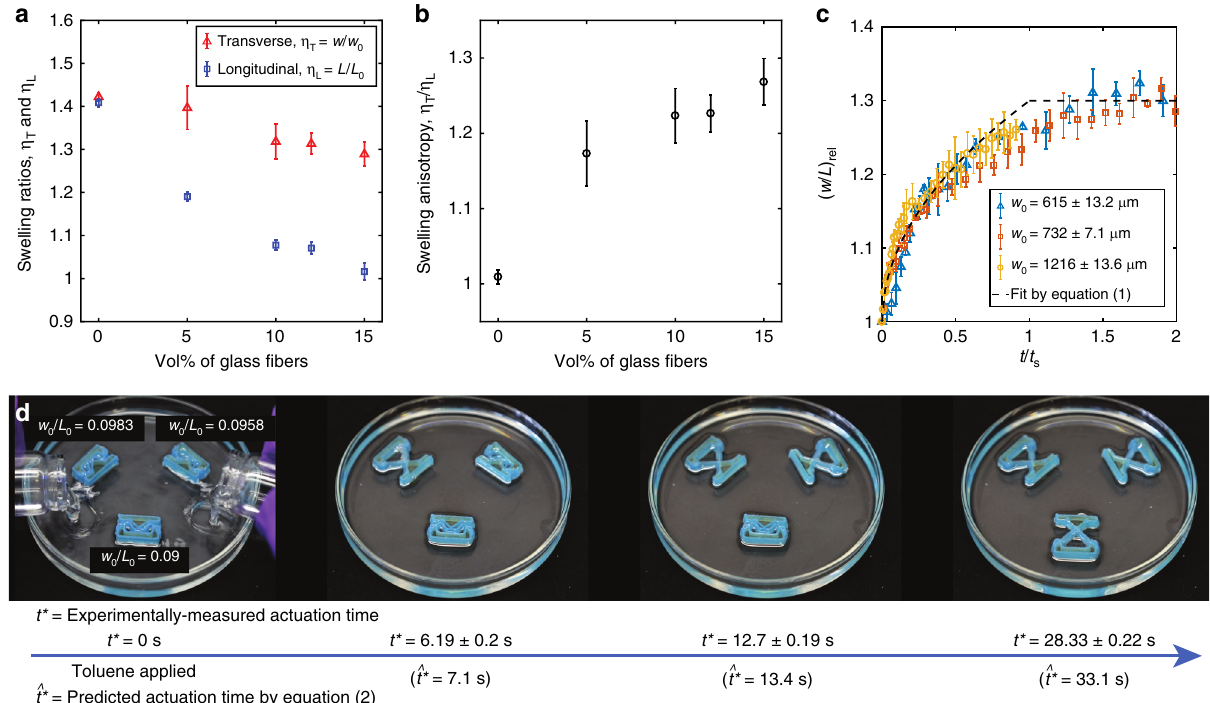
Fig. 4 Control of actuation time. a Swelling ratio in the transverse ( η T = w/w 0 ) and longitudinal ( η L = L / L 0 ) directions for PDMS – GF composite materials after submersion in toluene for one day. b Swelling anisotropy, η T/ η L as a function of volume fraction of glass fi bers. c The relative slenderness ratio ( w/L ) rel as a function of time for beams with different initial widths (time is normalized by saturation time, t s , to account for the dependence of diffusion time on volume of material). d Actuation time can be controlled by selecting speci fi c values for the initial beam geometry, w 0 / L 0 . The measured time t * is given, as well as the predicted time, ^ t (cid:4) , as calculated from equation (2). The error bars are the standard deviations computed from multiple